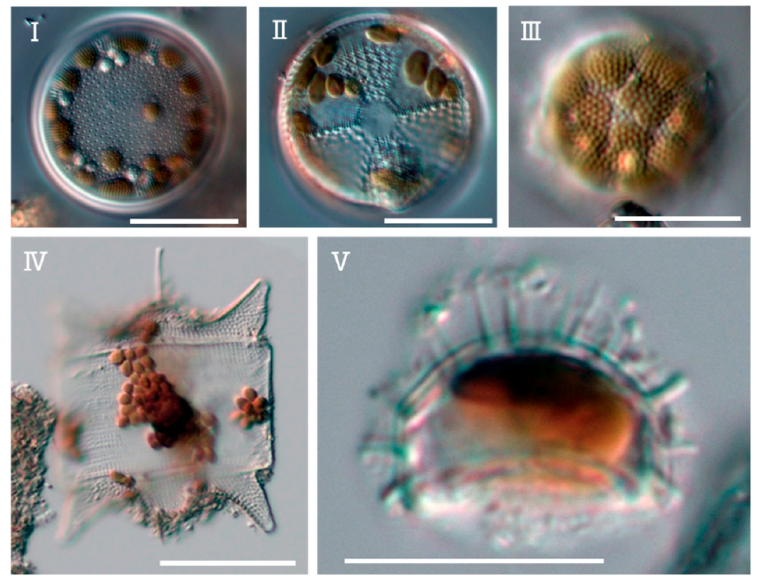
Figure 5. Photomicrographs of the resting stages of diatoms other than Chaetoceros spp. by direct microscopic observation; ( Ⅰ ) Actinocyclus sp., ( Ⅱ ) Actinoptychus senarius , ( Ⅲ ) Thalassiosira sp., ( Ⅳ ) Odontella aurita , and ( Ⅴ ) Leptocylindrus danicus . Scale bars are 20 µm.